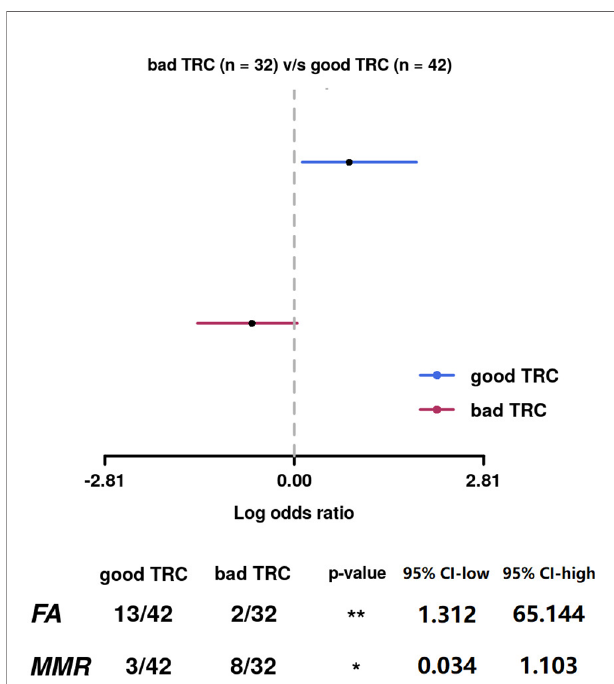
FIGURE 5 | The ef fi cacy of oxaliplatin-based treatment was positively correlated with FA pathway mutations, while negatively correlated with MMR pathway mutations. The correlations were both signi fi